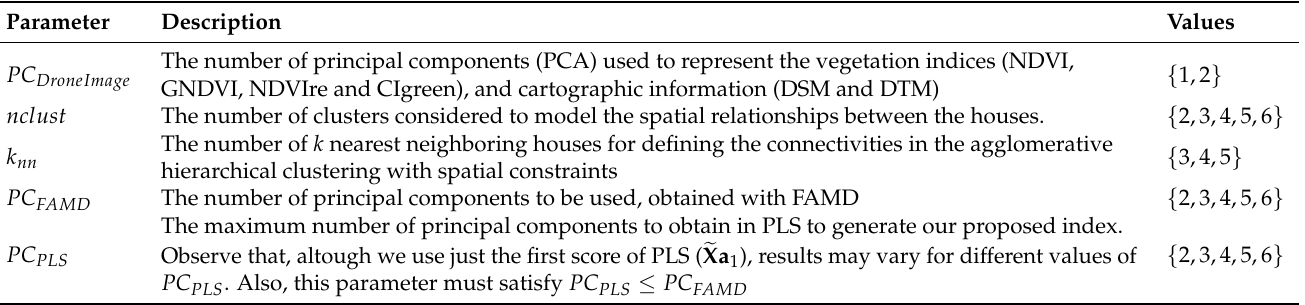
Table 2. Main parameters considered in our model. The possible values of those parameters were chosen arbitrarily based on the results we